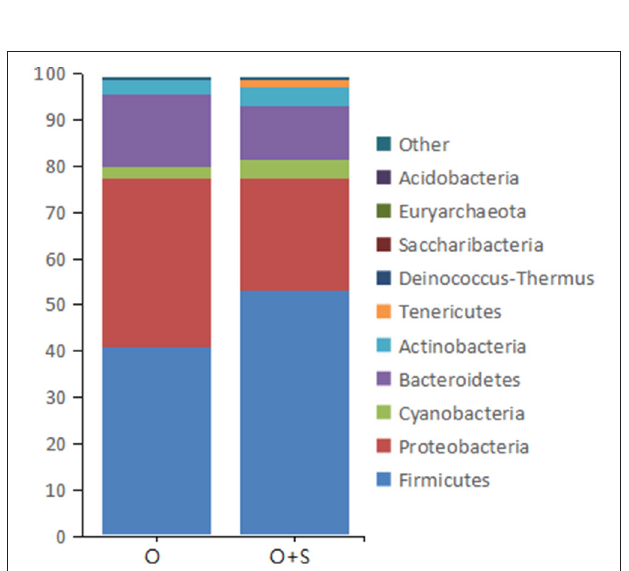
FIGURE 5 | The histograms showing the relative abundance of the top 10 phyla in the cecum of the overfeeding group and the supplementing group of geese ( n = 15). Note: the relative abundance was acquired from 16S rRNA analysis. The supplementing group of geese was overfed with the diet supplemented with lactobacillus. “O” and “O + S” denote the overfeeding group and the overfeeding + supplementing group, respectively.